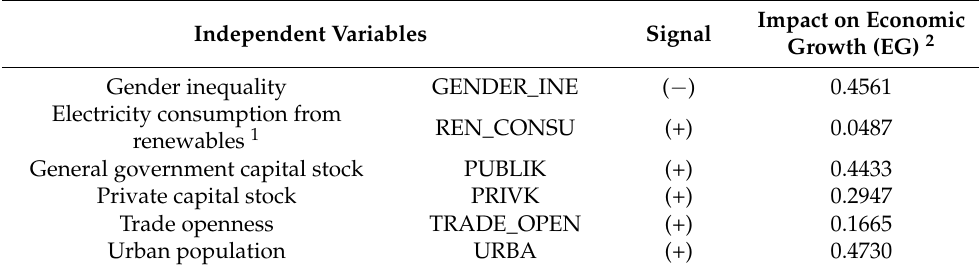
Table 11. Summary of the overall impacts obtained through OLS model estimation. Independent